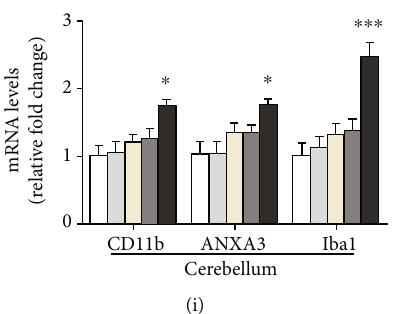
Figure 6: Spatiotemporal expression of ANXA3 protein and mRNA. (a, b) The expression levels of ANXA3 protein in rat embryos from E9.5 to E19.5 were determined by Western blotting analysis. The panel shows the protein bands corresponding to ANXA3 and tubulin. The histogram indicates the quanti fi cation of the densitometric analysis. The data are expressed as the means ± SD and were analyzed by one- way ANOVA with Tukey ’ s post hoc test. ∗ p < 0 : 05 and ∗∗ p < 0 : 01 compared with the E9.5 group. n = 6 per group. (c) Real-time PCR analysis of ANXA3 mRNA expression in rat embryos from E9.5 to E19.5. The data are expressed as the means ± SD and were analyzed by one-way ANOVA with Tukey ’ s post hoc test. ∗ p < 0 : 05 and ∗∗ p < 0 : 01 compared with the E9.5 group. n = 6 per group. (d – i) The levels of ANXA3 mRNA expression in the olfactory bulb, cortex, hippocampus, thalamus, cerebellum, and spinal cord of rats aged 1, 3, 6, 9, and 12 months were determined by qPCR analysis. The data are expressed as the means ± SD and were analyzed by one-way ANOVA with Tukey ’ s post hoc test. ∗ p < 0 : 05 , ∗∗ p < 0 : 01 , and ∗∗∗ p < 0 : 001 compared with the 1m group. n = 6 per group. 1m: 1 month; 3 m: 3